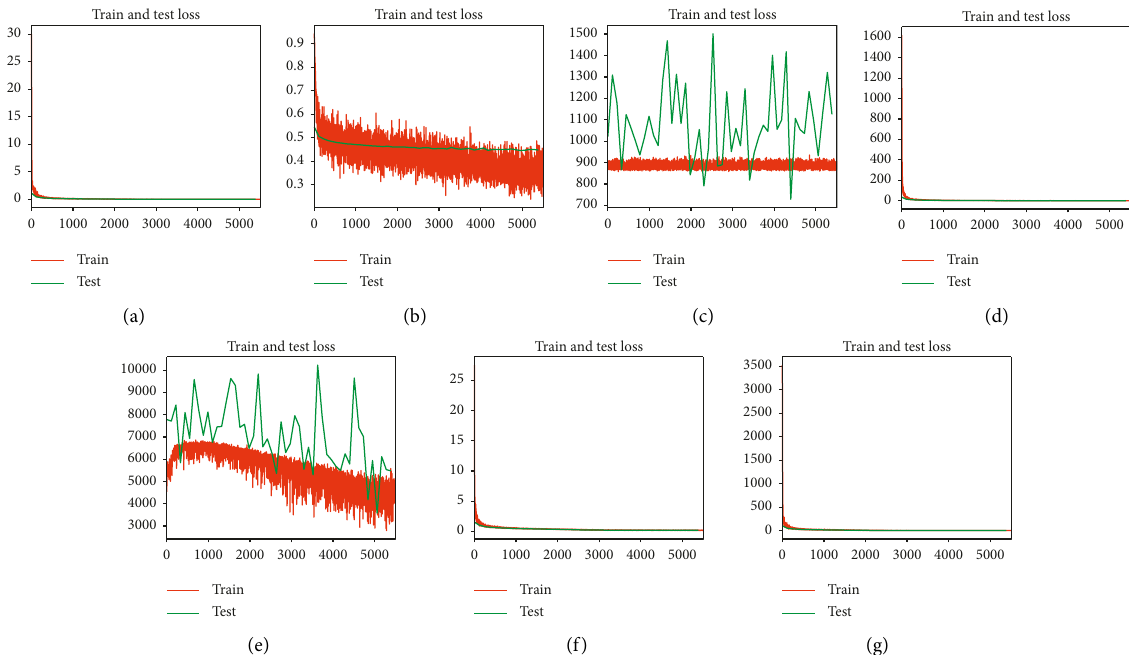
Figure 6: Deep learning training loss function curve corresponding to different combinations of loss functions. (a) MMSE. (b) Cosine Similarity. (c) 2D-DFT. (d) MMSE-2D-DFT. (e) Cosine Similarity-2D-DFT. (f) MMSE-cosine Similarity. (g) MMSE-cosine Similarity-2D-